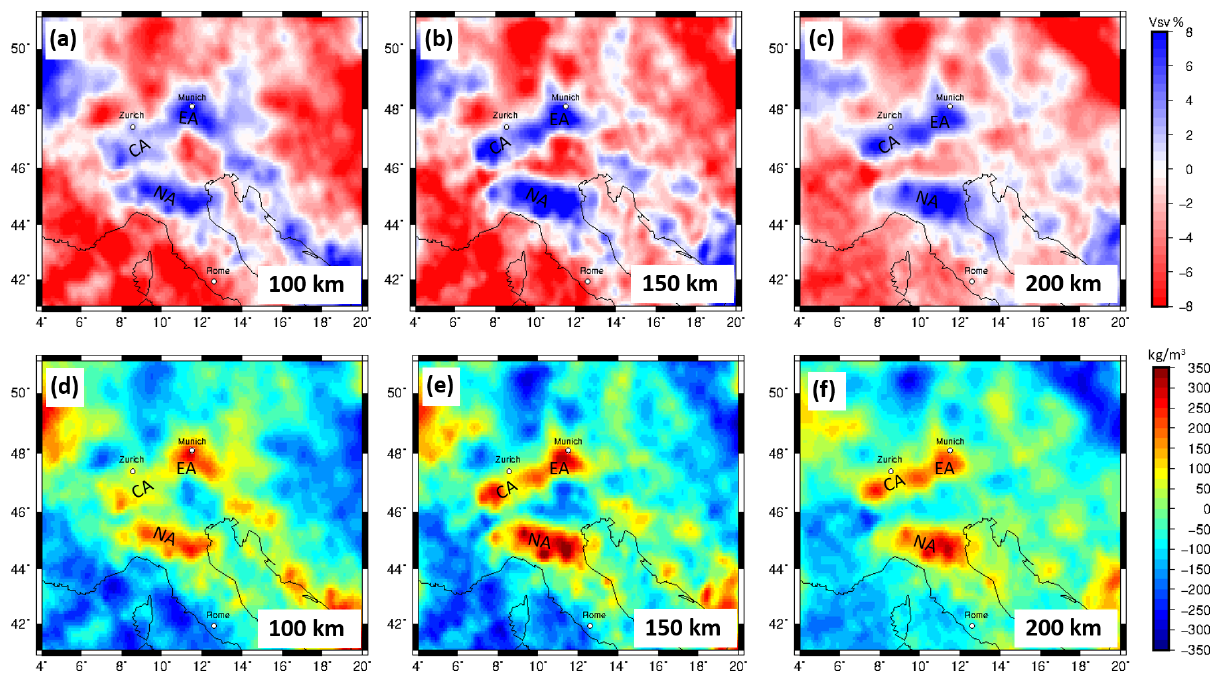
Figure 3. (a–c) Depth slices of relative surface wave velocities ( V sv ) from MeRE2020 (El-Sharkawy et al., 2020). (d–f) Converted relative density distribution in different depths based on a conversion factor ( ζ ) of 0.3. CA – Central Alpine slab; EA – Eastern Alpine slab; NA – Northern Apennine slab.